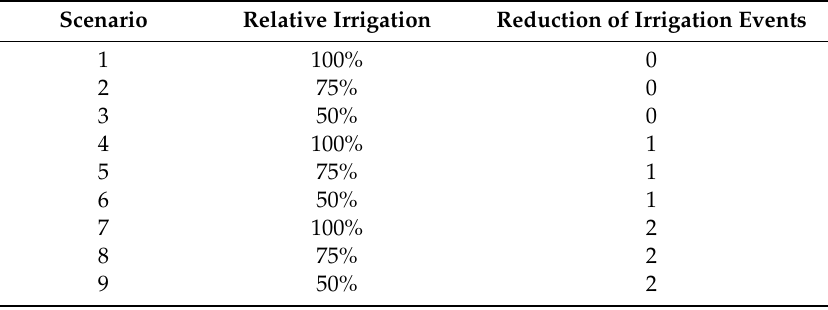
Table 3. Modeled irrigation strategies relative to the optimum irrigation amount per irrigation event S Ix % and to the optimum number of irrigation events S IE − n